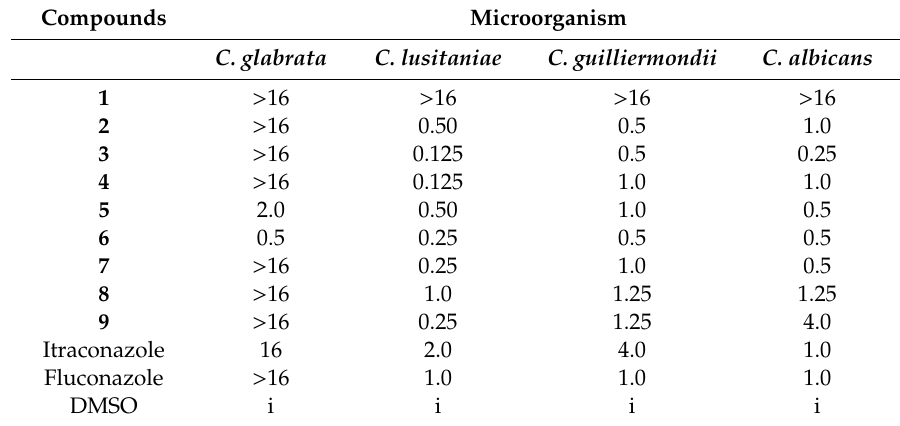
Table 1. Antifungal activities determined in a liquid medium and expressed by a MIC 80 in μg/mL at 24 h.